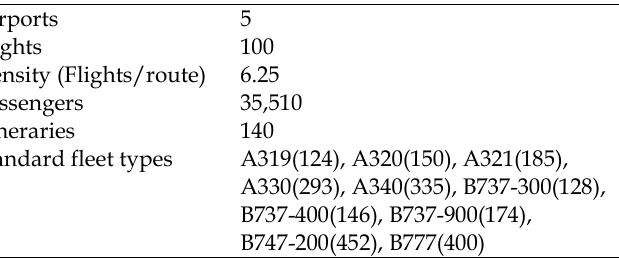
Table 11. Data instance for the tests with different available capacity